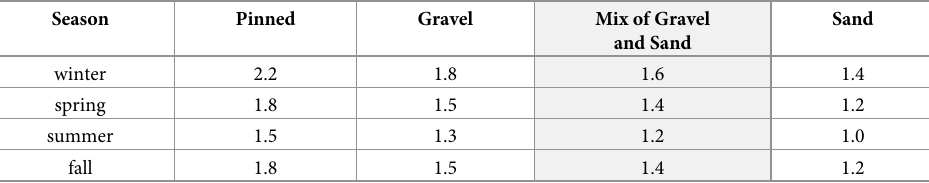
Table 1. Variation of interaction equation value as function of type of debris clogging the joint.